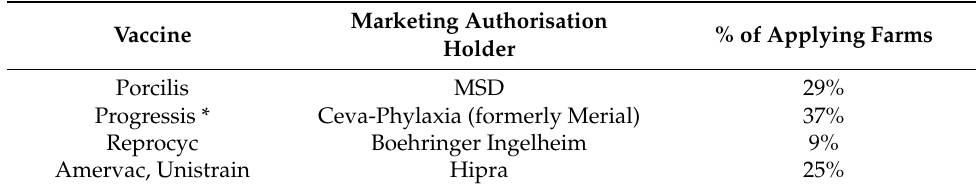
Table 1. Data of the vaccine strains used in Hungary.